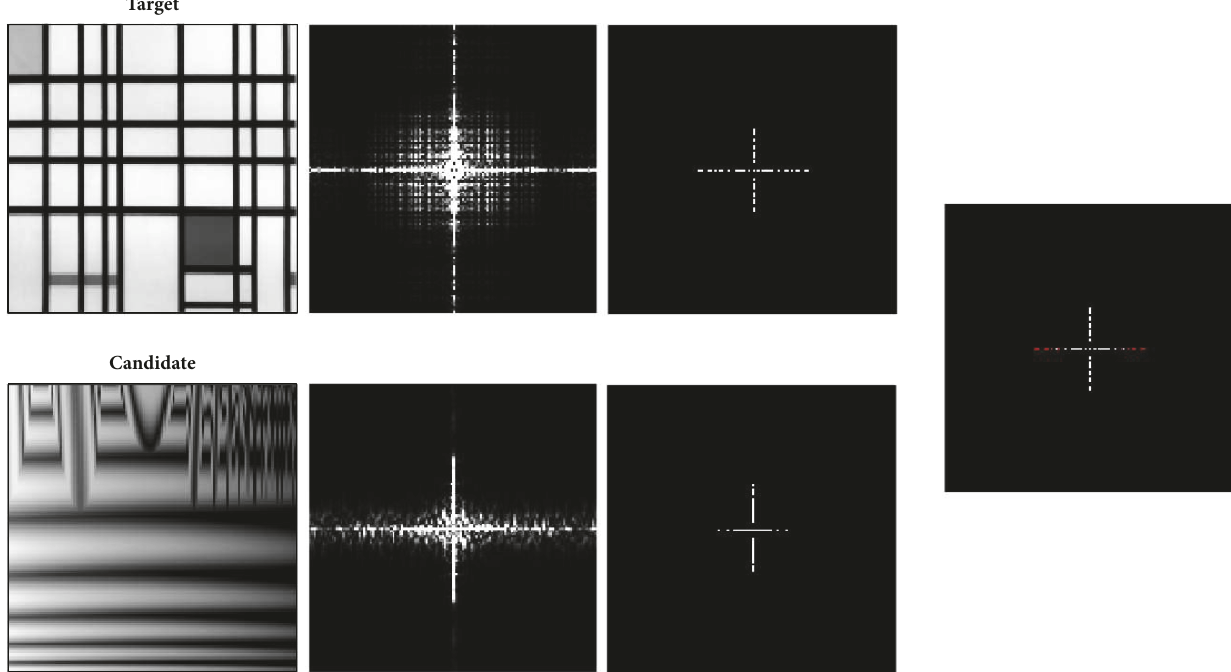
Figure 5: Truncation and quantization example. Target and candidate coefficient sets were reduced to the top 𝐾 = 50 most powerful positions and then quantized to 0, 1 , before checking for matches. The rightmost image shows the top 𝐾 positions matching between target and candidate, with those absent from the target being displayed in